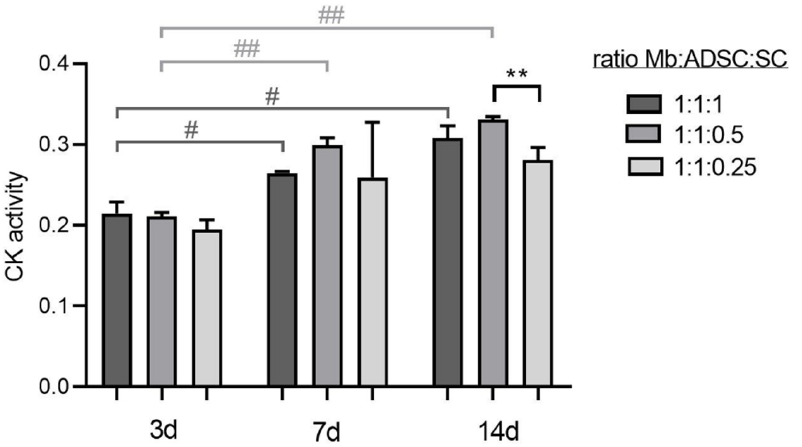
Figure 4. Optimal ratio of Mb/ADSC/SC determined with creatine kinase (CK) activity. Values are presented in mean ± standard deviation. CK activity increased over time within 1:1:1 (# p < 0.05, repeated measures ANOVA with Tukey’s correction for multiple comparisons) and 1:1:0.5 (## p < 0.01, repeated measures ANOVA with Tukey’s correction for multiple comparisons). After 14 days, CK activity was lower in 1:1:0.25 groups compared to 1:1:0.5 groups (** p < 0.01, one way ANOVA with Tukey’s correction for multiple comparisons). Based on those results, Mb/ADSC/SC were used at a ratio of 1:1:0.5 for further